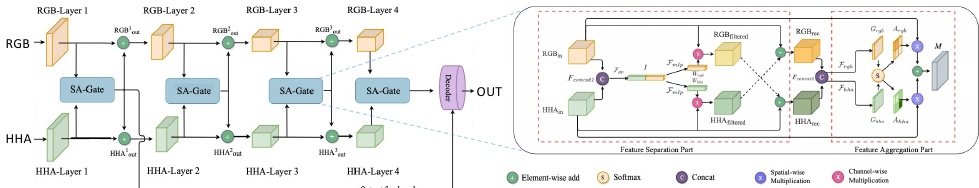
Figure 5. Figure from [101] showing its cross-modality feature propagation scheme. Adapted with authors’ permission from [101]. Copyright 2020, Springer Nature Switzerland AG.